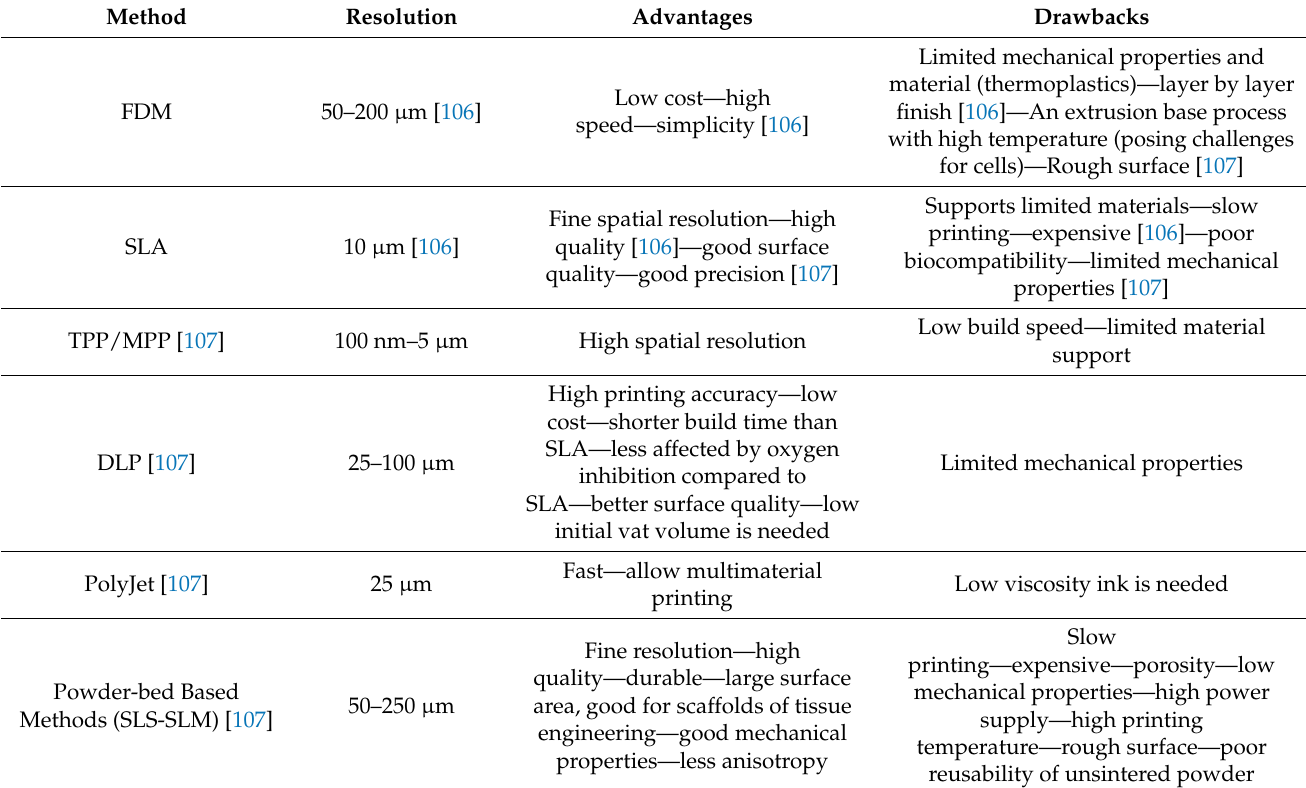
Table 2. Commonly used 3D printing methods for microfluidic chip fabrication and 3D